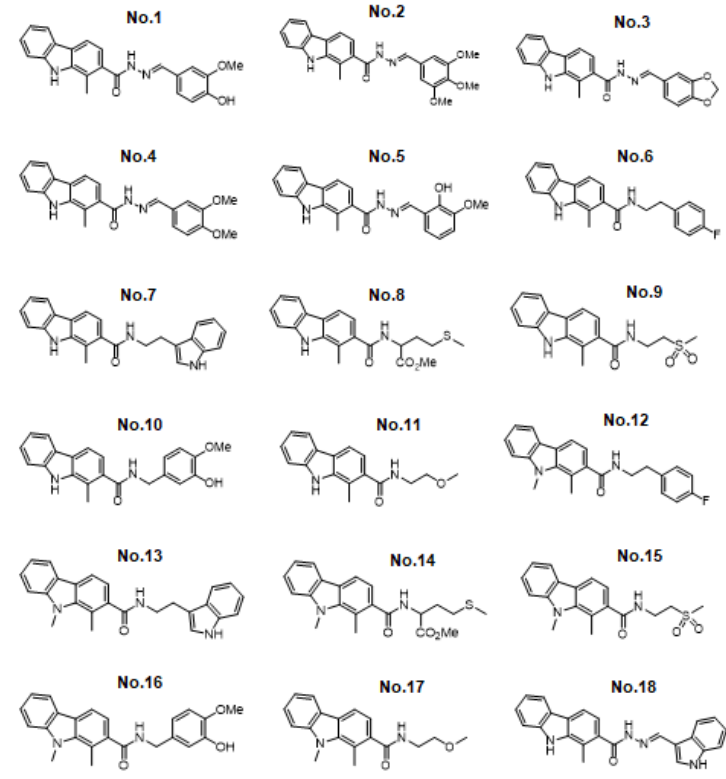
Figure 1. Chemical structures of 18 synthetic carbazole Figure 1 . Chemical structures of 18 synthetic carbazole alkaloids.